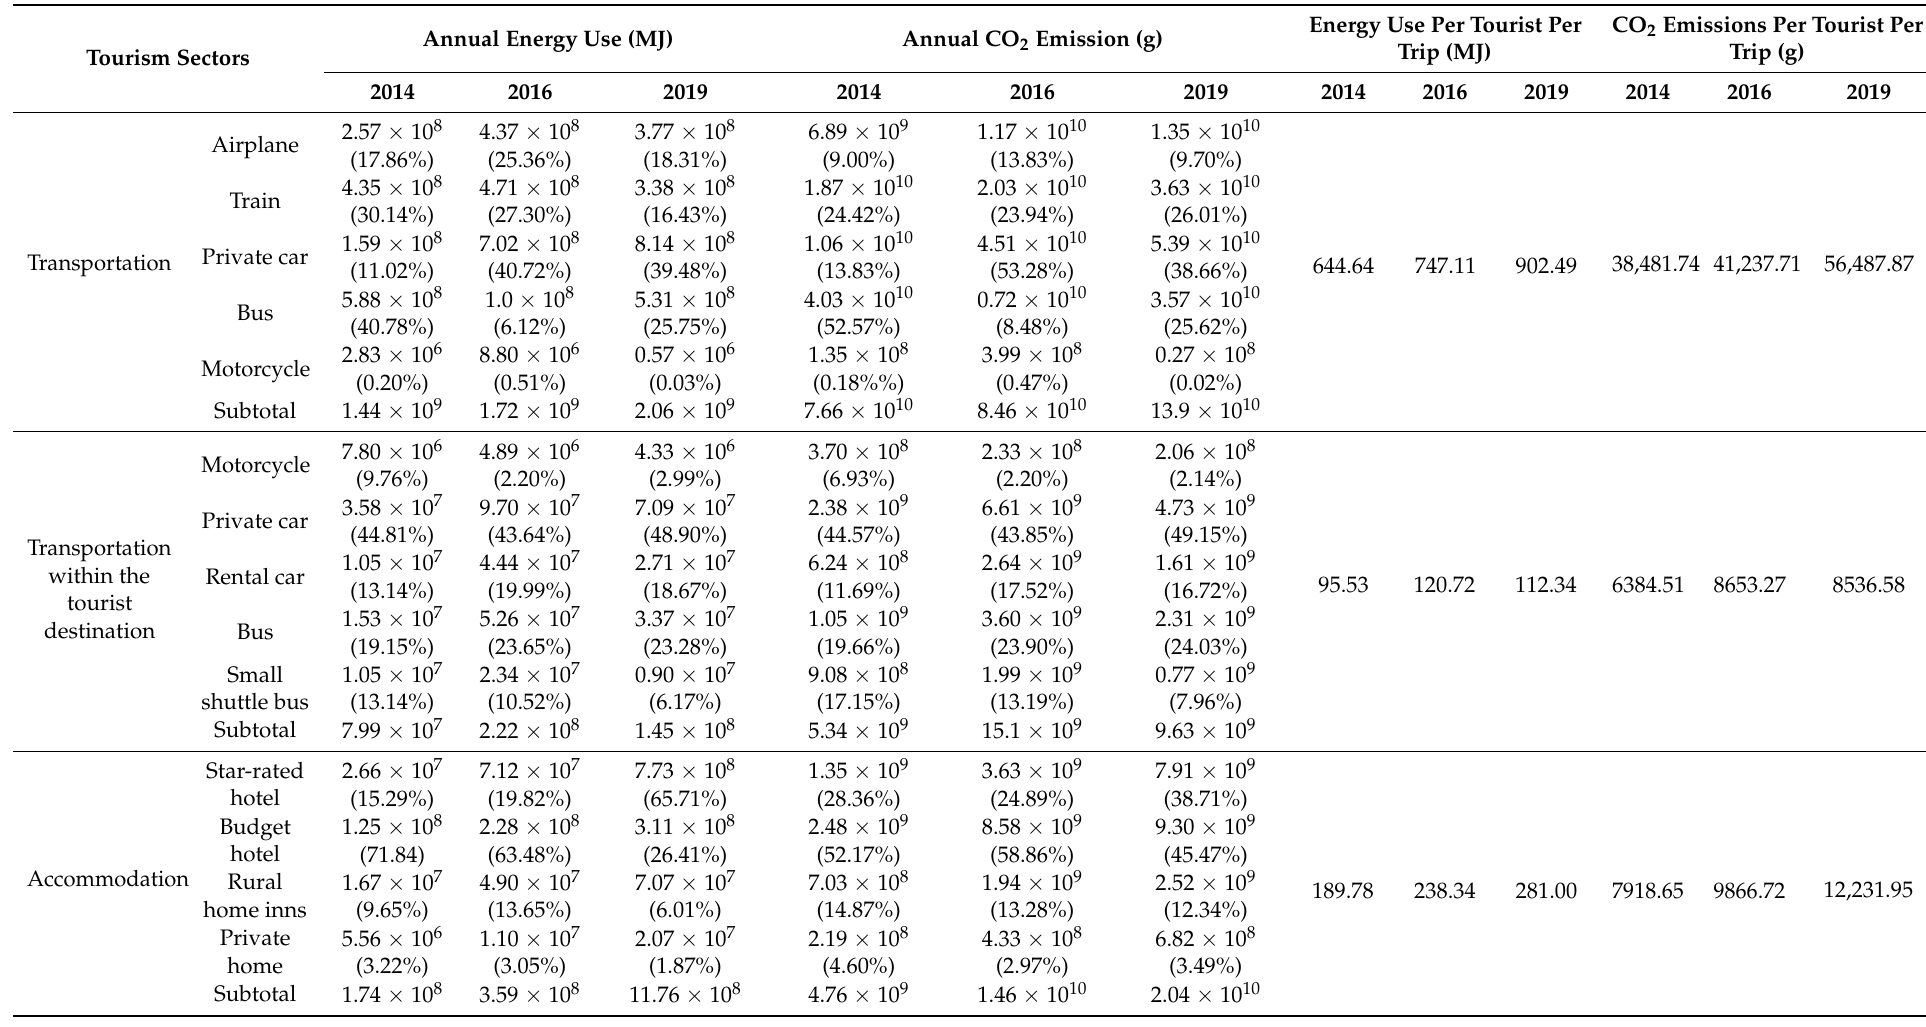
Table 5. Annual energy uses and CO 2 emissions of different